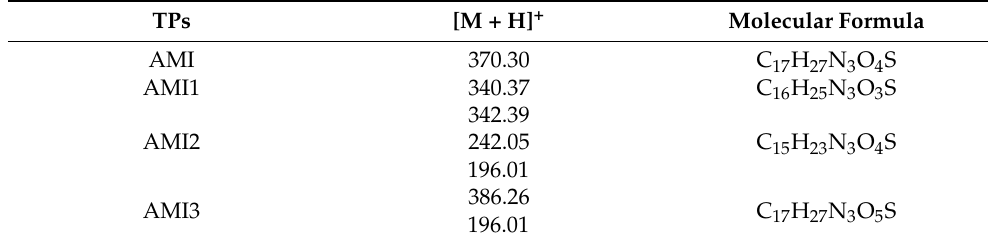
Table 3. Mass measurements ([M+H] + ) and molecular formula of the identified TPs.